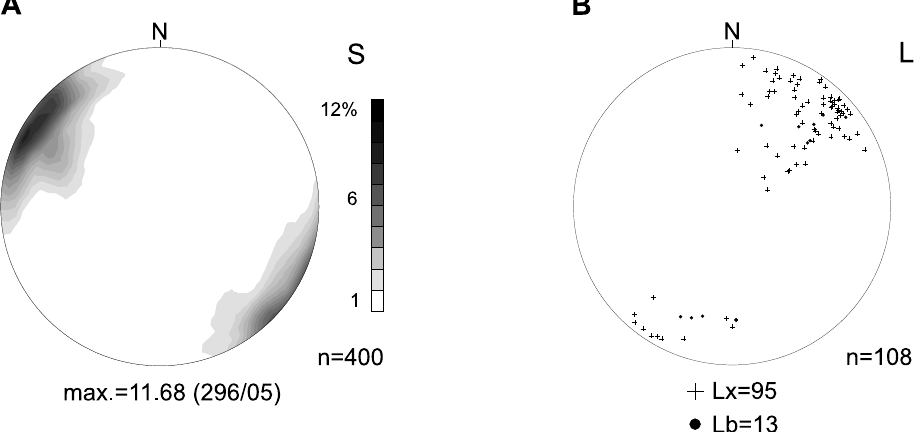
Fig. 3 – Structural data of Eastern Structural Domain. A – Poles to foliation (S), B – Poles to fold planes (SF) with statistically adjusted axis, C – Linear data (L): Lx – mineral and stretching lineation, Lb – fold axis. Equal area lower hemisphere Schmidt-Lambert stereographic projection. Number of data points (n) shown.